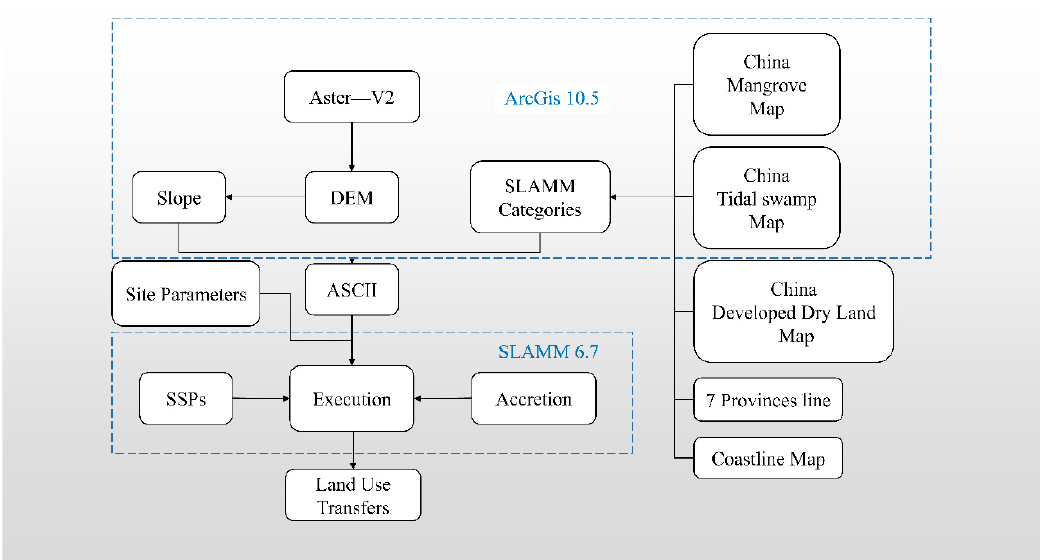
Figure 1. Work fl ow of the approach followed for this study. Figure 1. Workflow of the approach followed for this study.